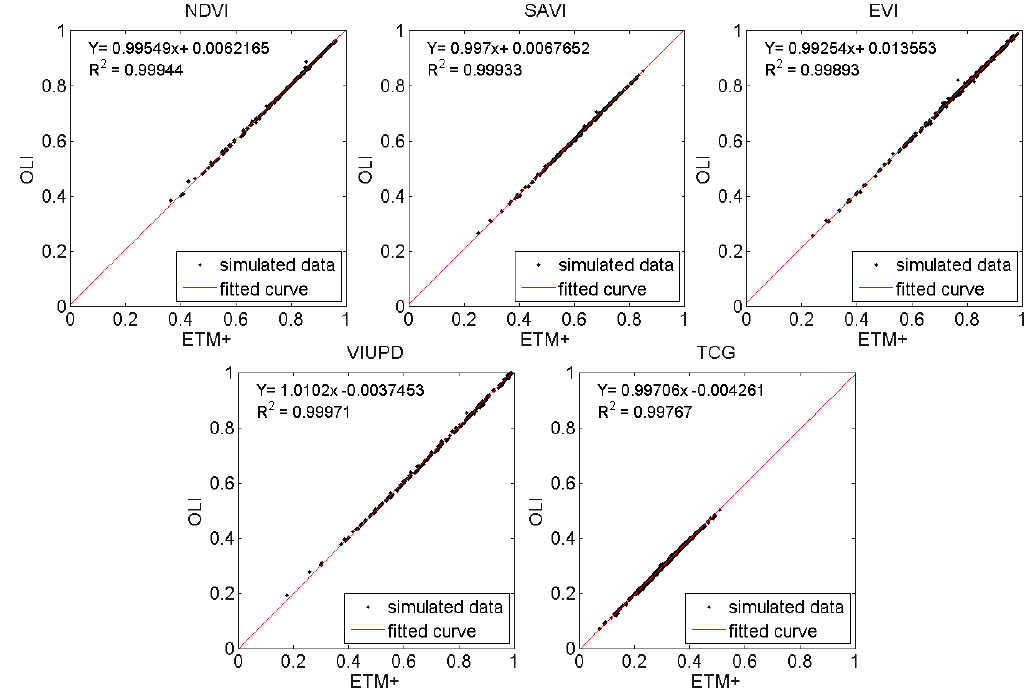
Figure 5. Correlations among vegetation indices (NDVI, SAVI, EVI, VIUPD, and TCG,) determined using ETM+-derived data (x-axis)- and OLI-derived data (y-axis). Data was spectrally convoluted from ground measured spectra (number of samples = 393) to at-sensor reflectance.